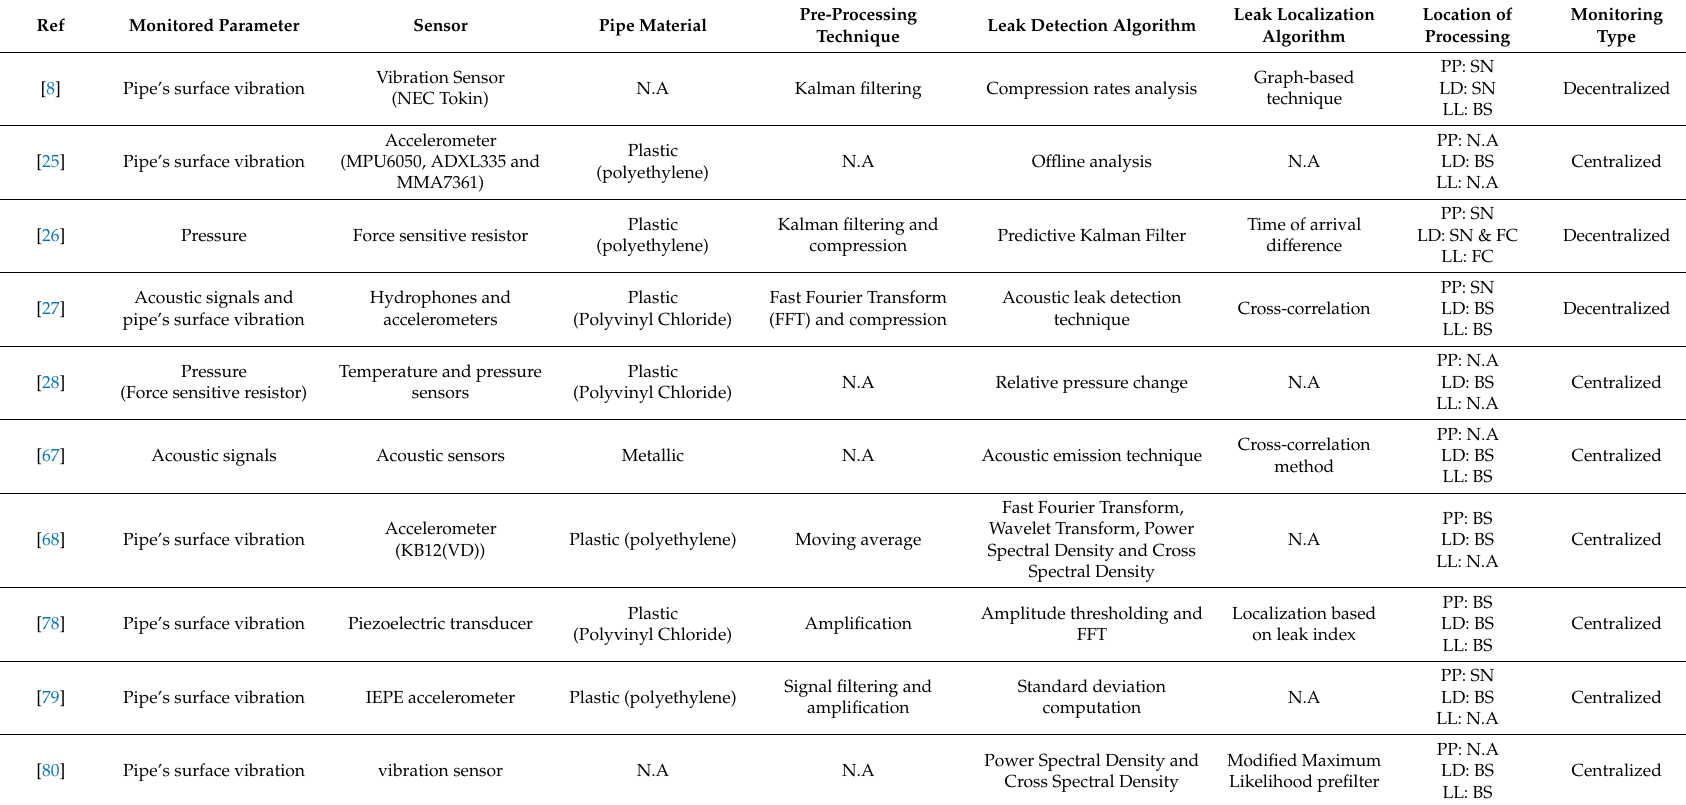
Table 2. Summary comparison of some selected studies in